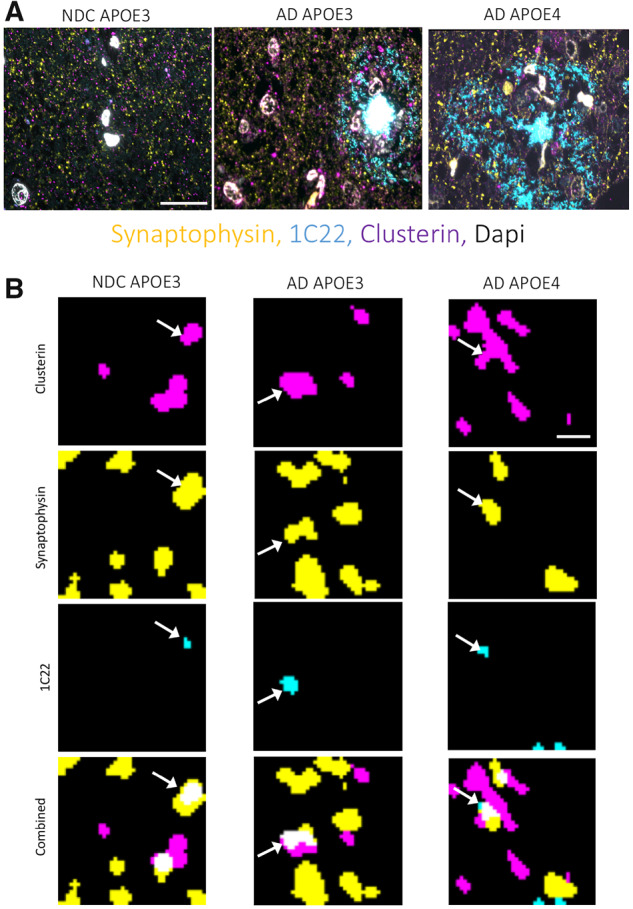

Representative images of array tomography staining. Array tomography ribbons from non-demented controls (NDC), Alzheimer's disease APOE3 and Alzheimer's disease APOE4 individuals were stained for pre-synapses (synaptophysin, yellow), oAβ (1C22, cyan) and clusterin (magenta). Images shown in (A) are maximum intensity projections of four serial sections (aligned raw images). Images shown in (B) are maximum intensity projections of two serial sections from analysed image stacks that have been thresholded and single section noise removed in MATLAB. Each channel is shown separately with the merge in the bottom image. Arrows indicate synapses containing both clusterin and oAβ staining. Scale bars represent 15 μm (A) and 1 μm (B).